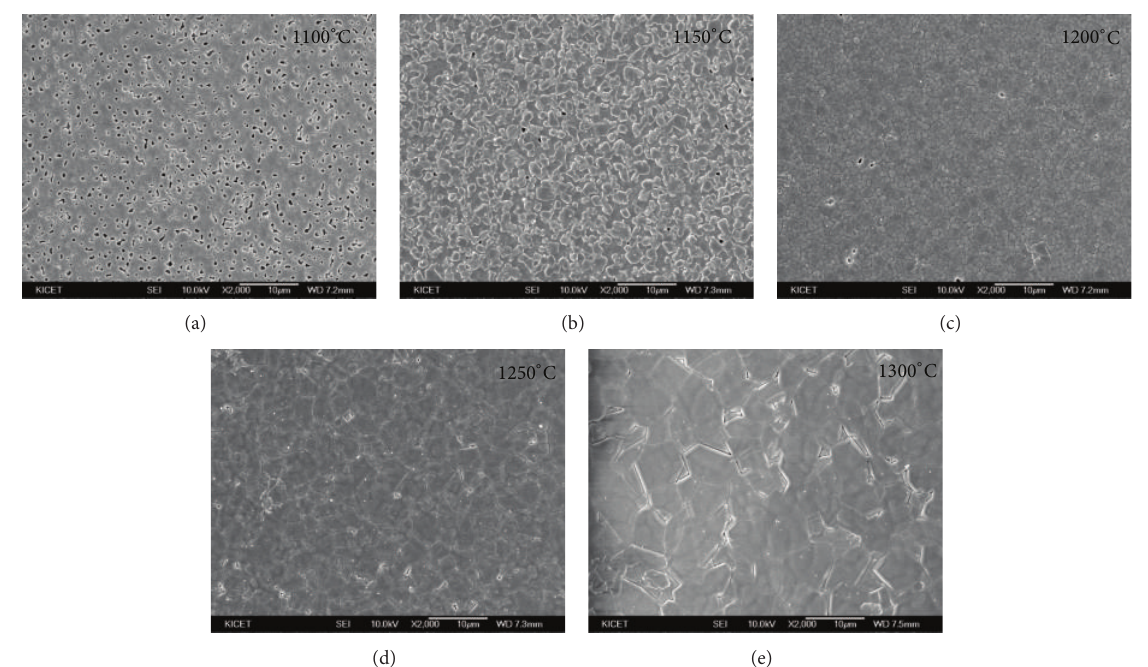
Figure 2: Micro-structure images of 60TCP40HA sintered body according to the temperature.